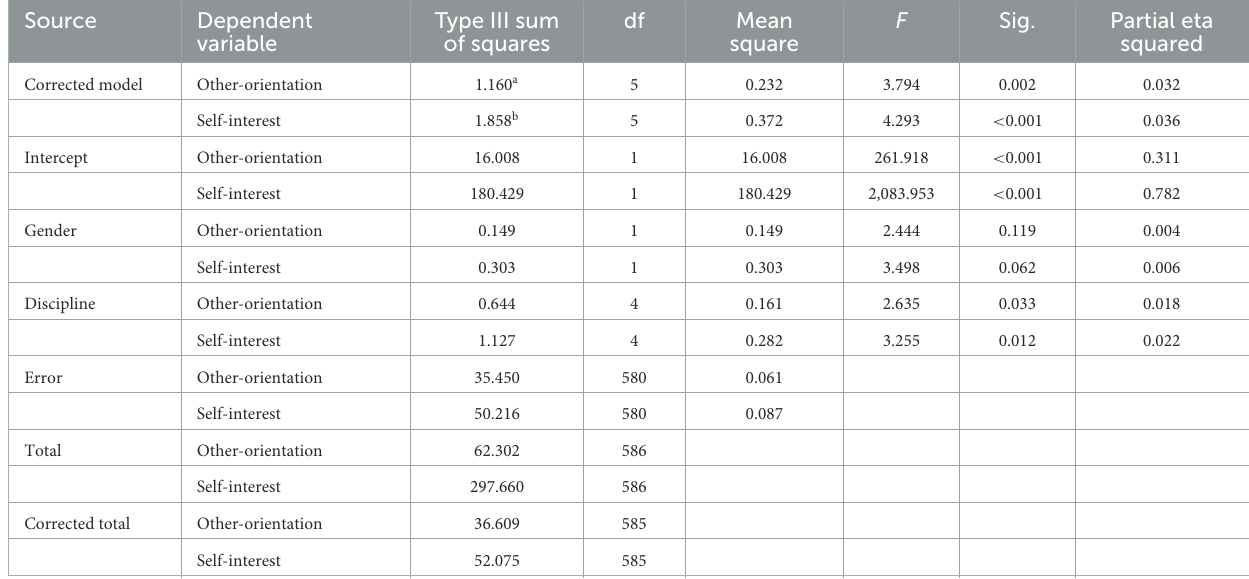
TABLE 4 Two-way MANOVA Tests of Between-Subjects Effects on other-orientation and self-interest simultaneously ( n = 586).